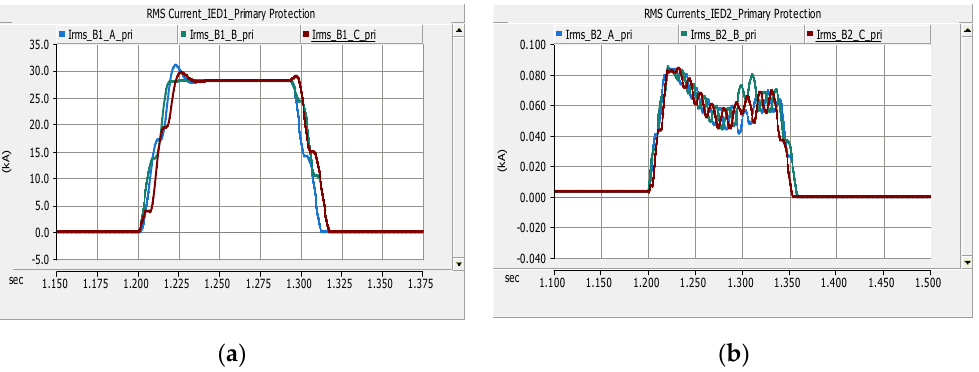
Figure 10. RMS magnitude of the current before, during and after fault F1 at: ( a ) IED1 and ( b ) IED2 (CB2 transfer trip).